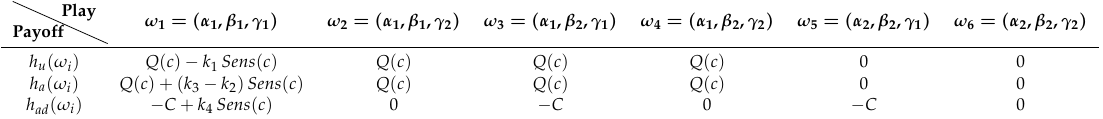
Table 1. The payoff of the players in different